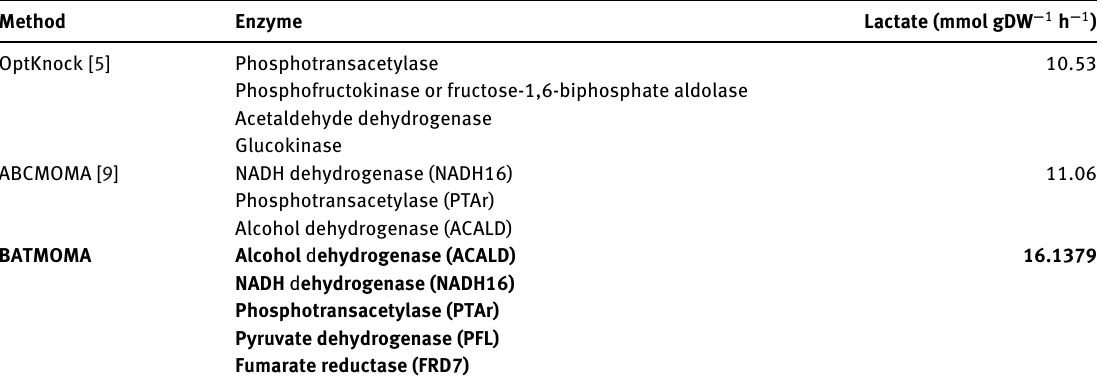
Table 4: Comparative analysis for lactate